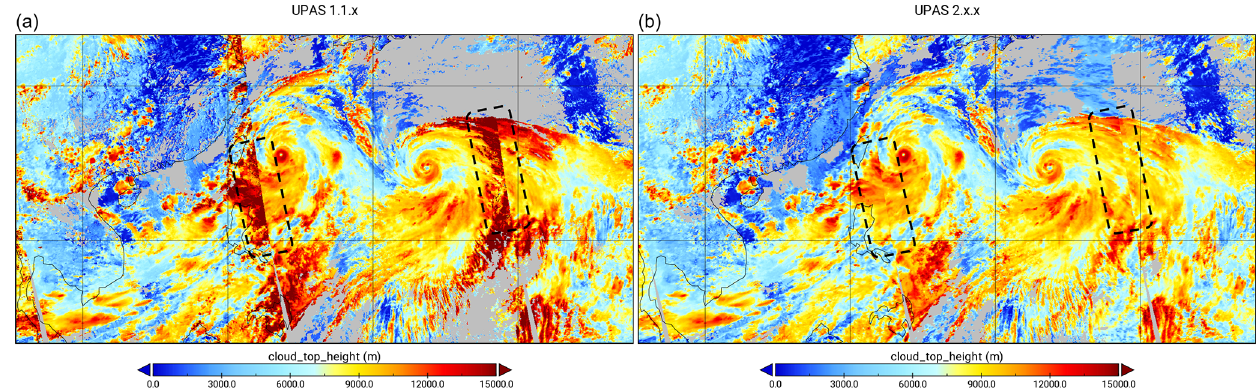
Figure 13. Panel (a) shows S5P OCRA/ROCINN_CAL CTH of parts of orbits 09416, 09417, and 09418 on 8 August 2019 for CLOUD OFFL 1.1.7. Similar for panel (b) but for CLOUD version 2 (right). Note the regions with sharper contrast in CTH across orbit edges for version 1 which have largely disappeared for version 2 (indicated with black dashed rectangles).